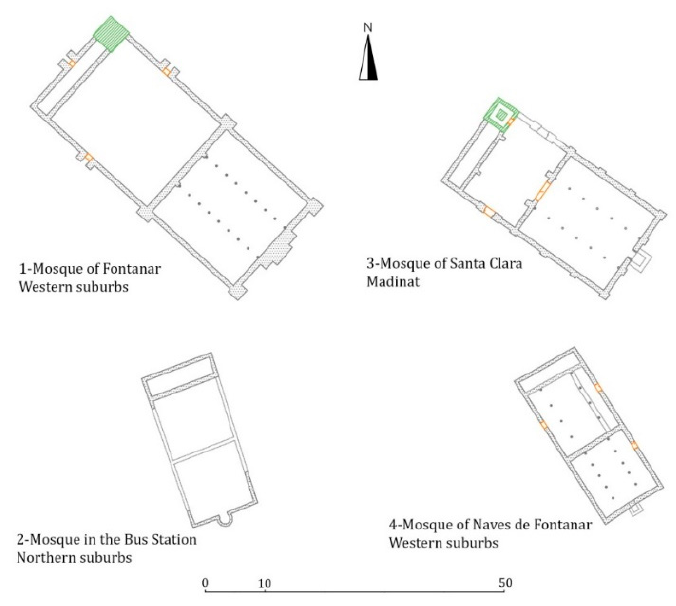
Figure 4. Caliphal mosques in Córdoba. Their plant consists on a squared prayer room, followed by an also squared courtyard often provided with a minaret (Created by Author).